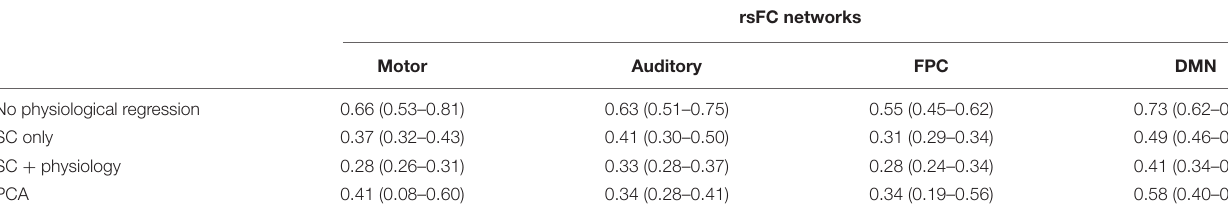
TABLE 1 | Average (interquartile range) Euclidean distance across different pairs of